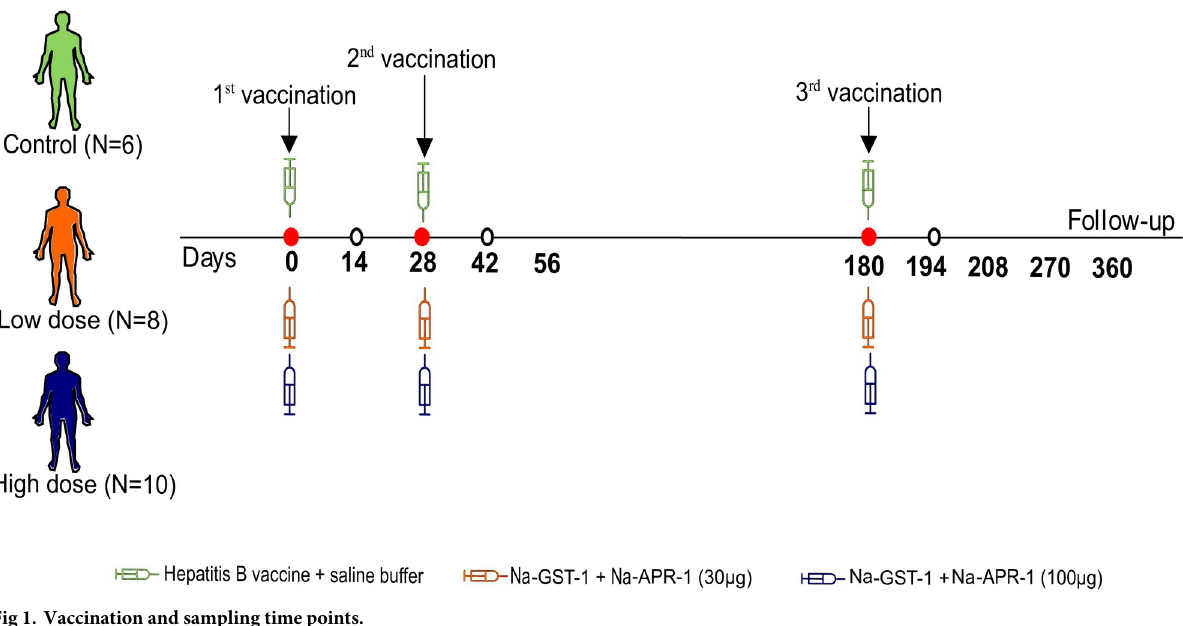
Fig 1. Vaccination and sampling time